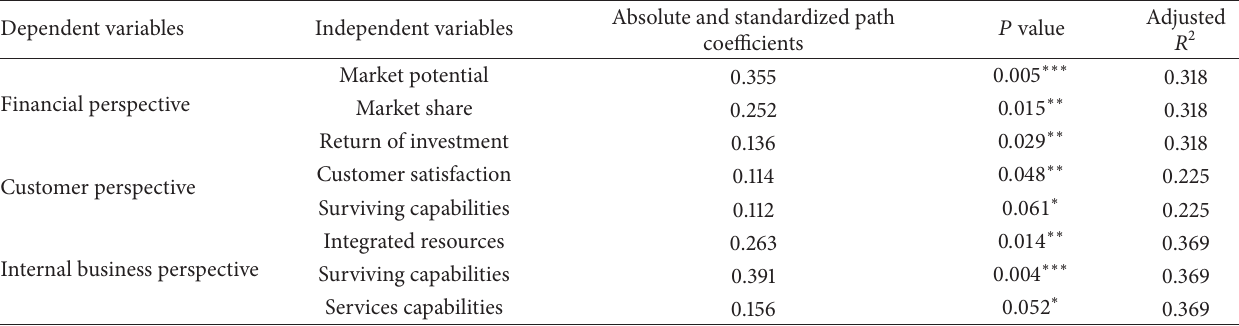
Table 5: Path analysis between 13 extracted CSFs and 4 performance perspectives. (Small technology-based firms expended by differentiated